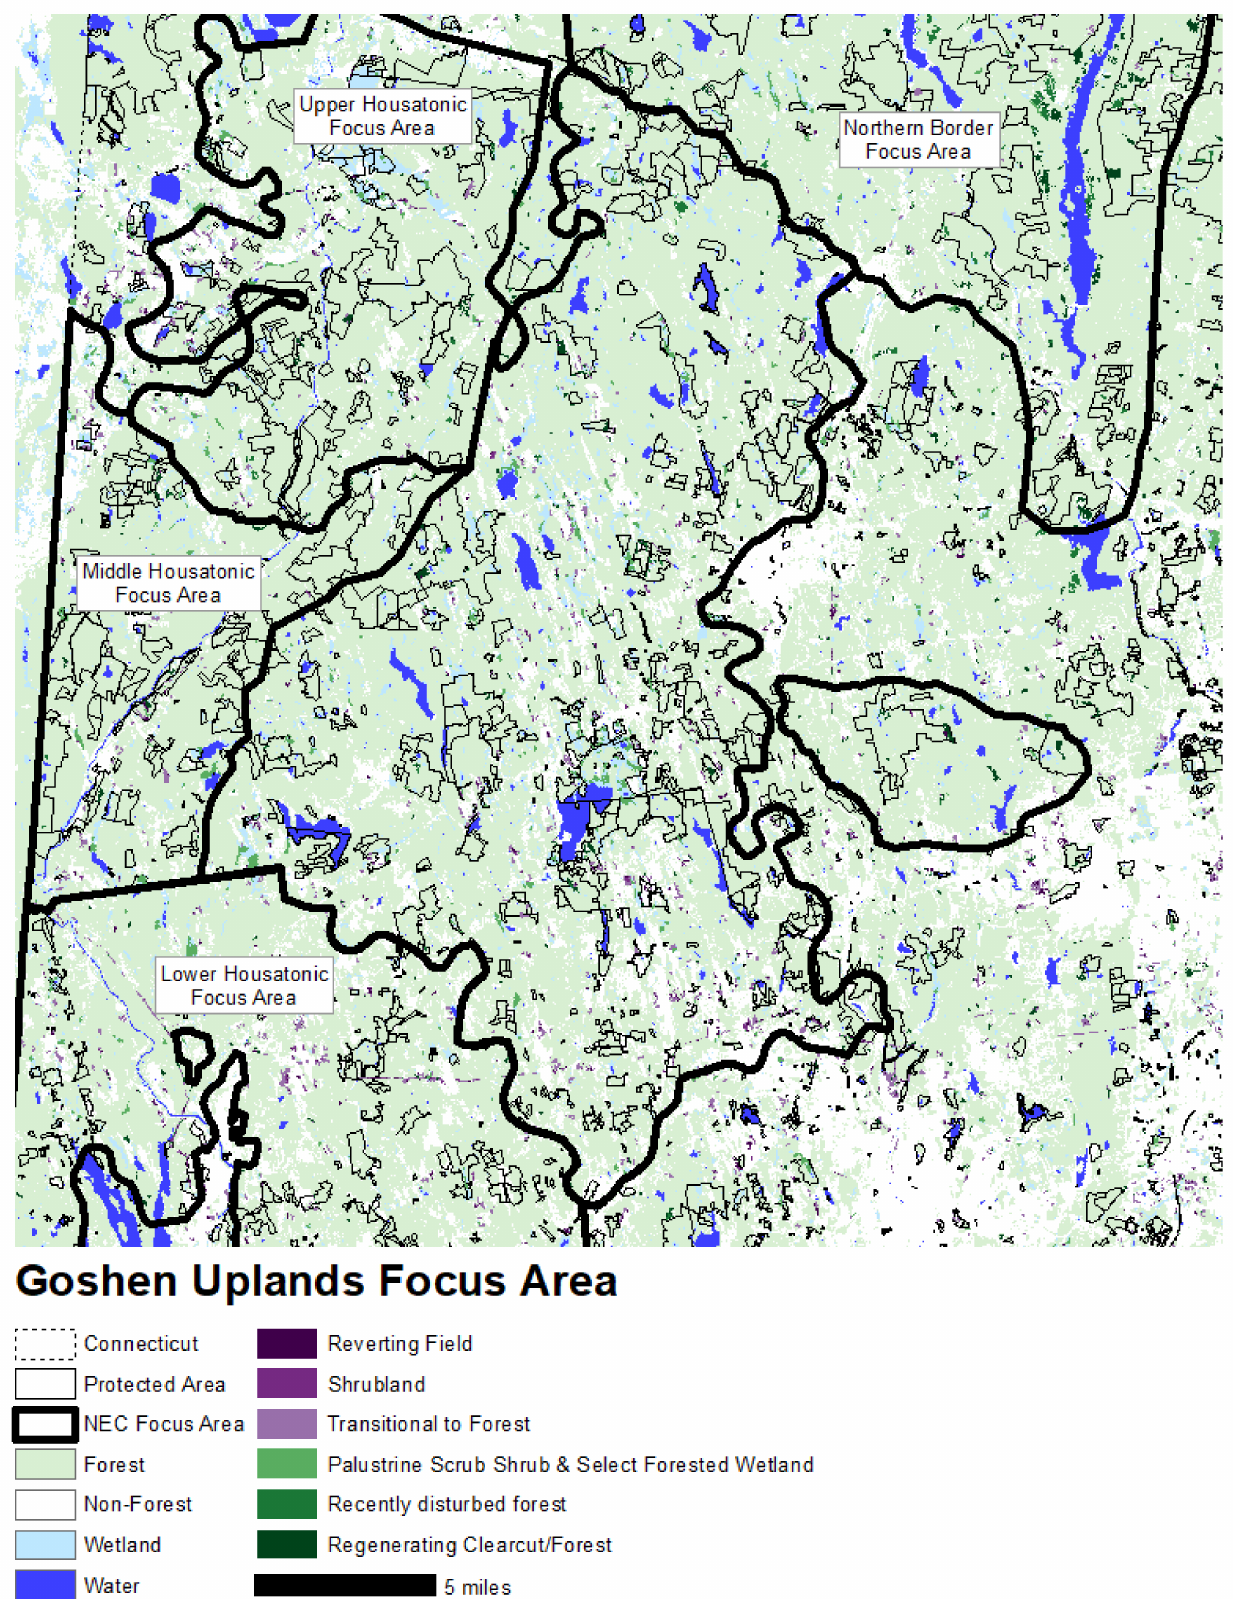
Figure 6. Young forest, shrubland, and palustrine scrub-shrub and forested wetlands in the Goshen Upland Focus Area,